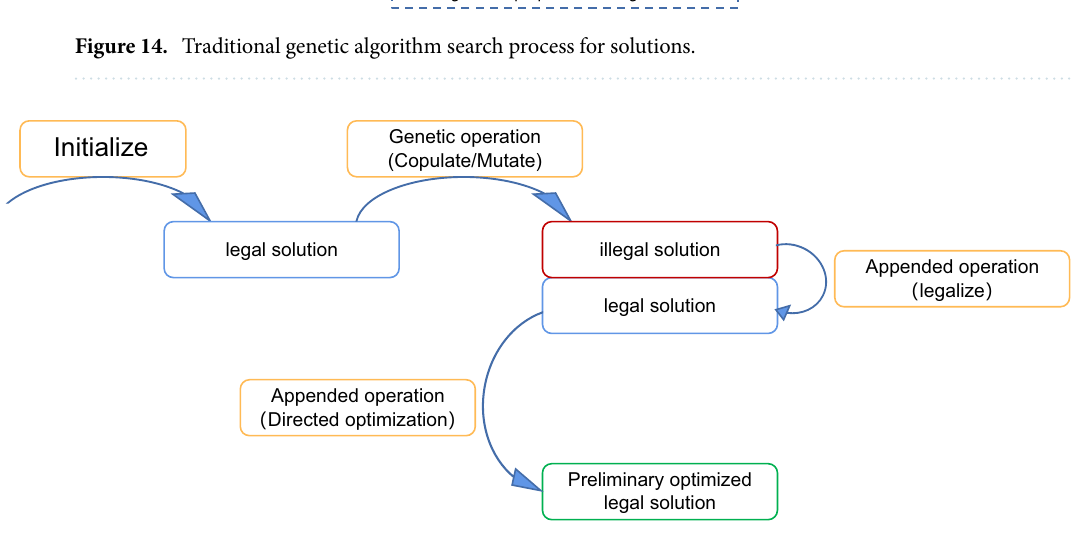
Figure 15. Improved genetic algorithm search process for